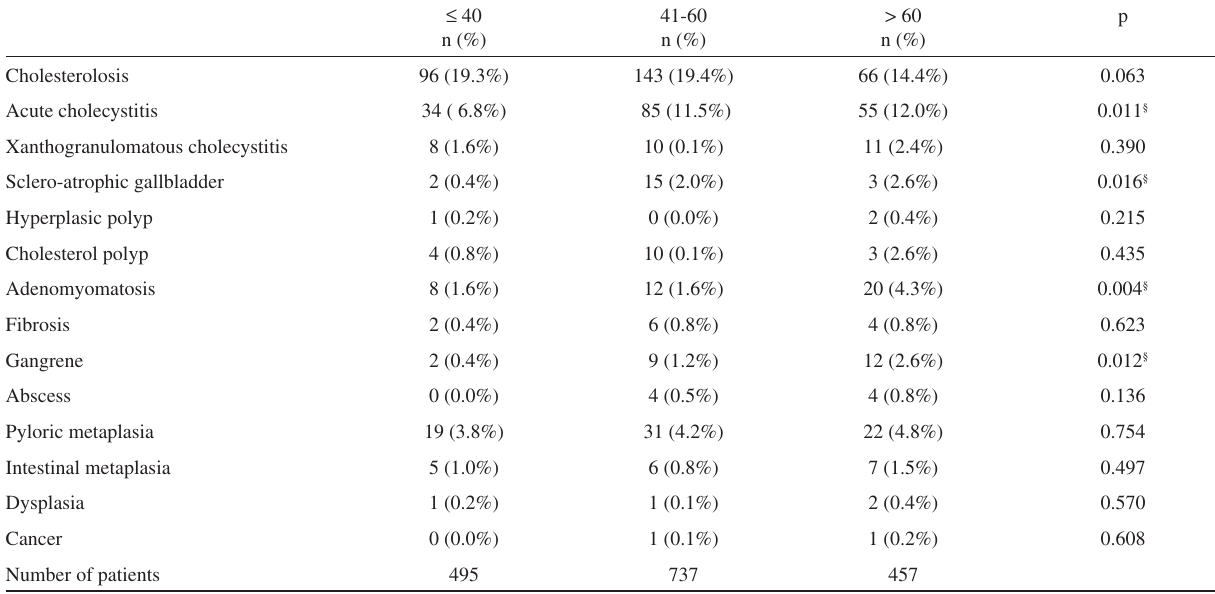
Table 3 - Analysis of the gallbladder histological alterations according to